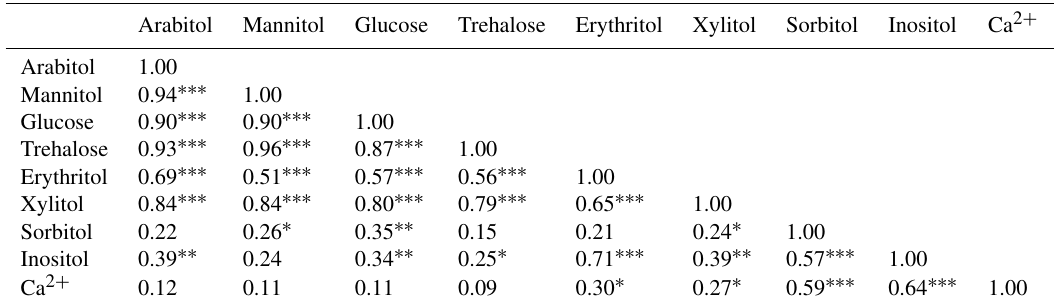
Table 1. Relationships between SCs and calcium in PM 10 from the study site. Spearman’s rank correlation analyses are based on the daily dynamics of chemical species ( n = 69). Arabitol Mannitol Glucose Trehalose Erythritol Xylitol Sorbitol Inositol Ca 2 + Arabitol 1.00 Mannitol 0.94 ∗∗∗ 1.00